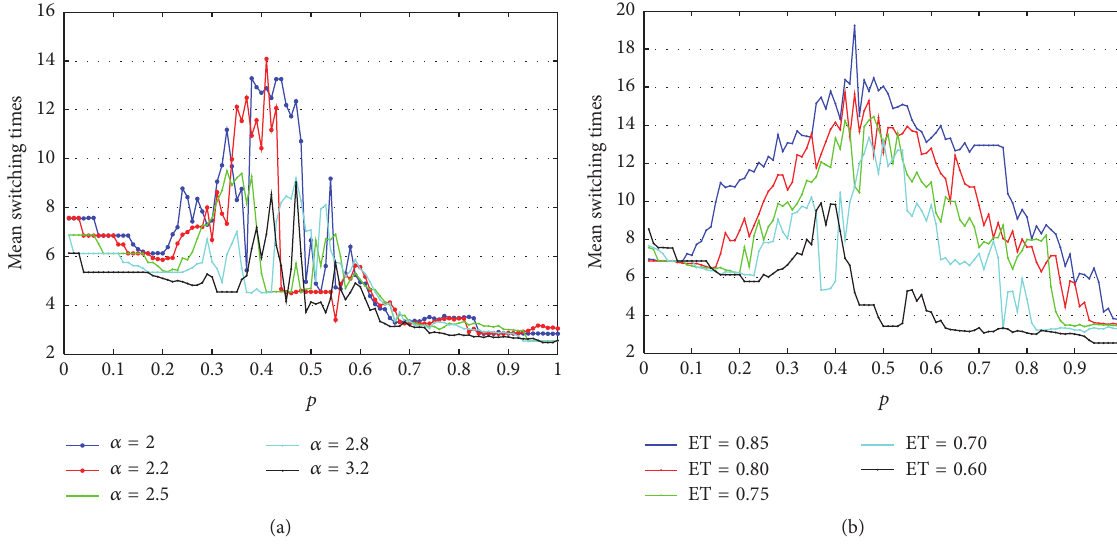
Figure 7: Mean switching times versus 𝑝 . The parameter values are fixed as follows: 𝑝 = 0.1, 𝜏 = 0.3, 𝜎 = 0.66, 𝛽 = 4 , and 𝛿 = 2.0 ; the initial density of prey and predator (𝑥 0 , 𝑦 0 ) = (0.2, 0.5) . (a) ET = 0.6 and 𝛼 = 2,2.2, 2.5, 2.8, 3.2 , respectively. (b) 𝛼 = 2 and ET = 0.85, 0.80, 0.75, 0.70, 0.60 , respectively. Mean switching times are calculated between 50 and 2050